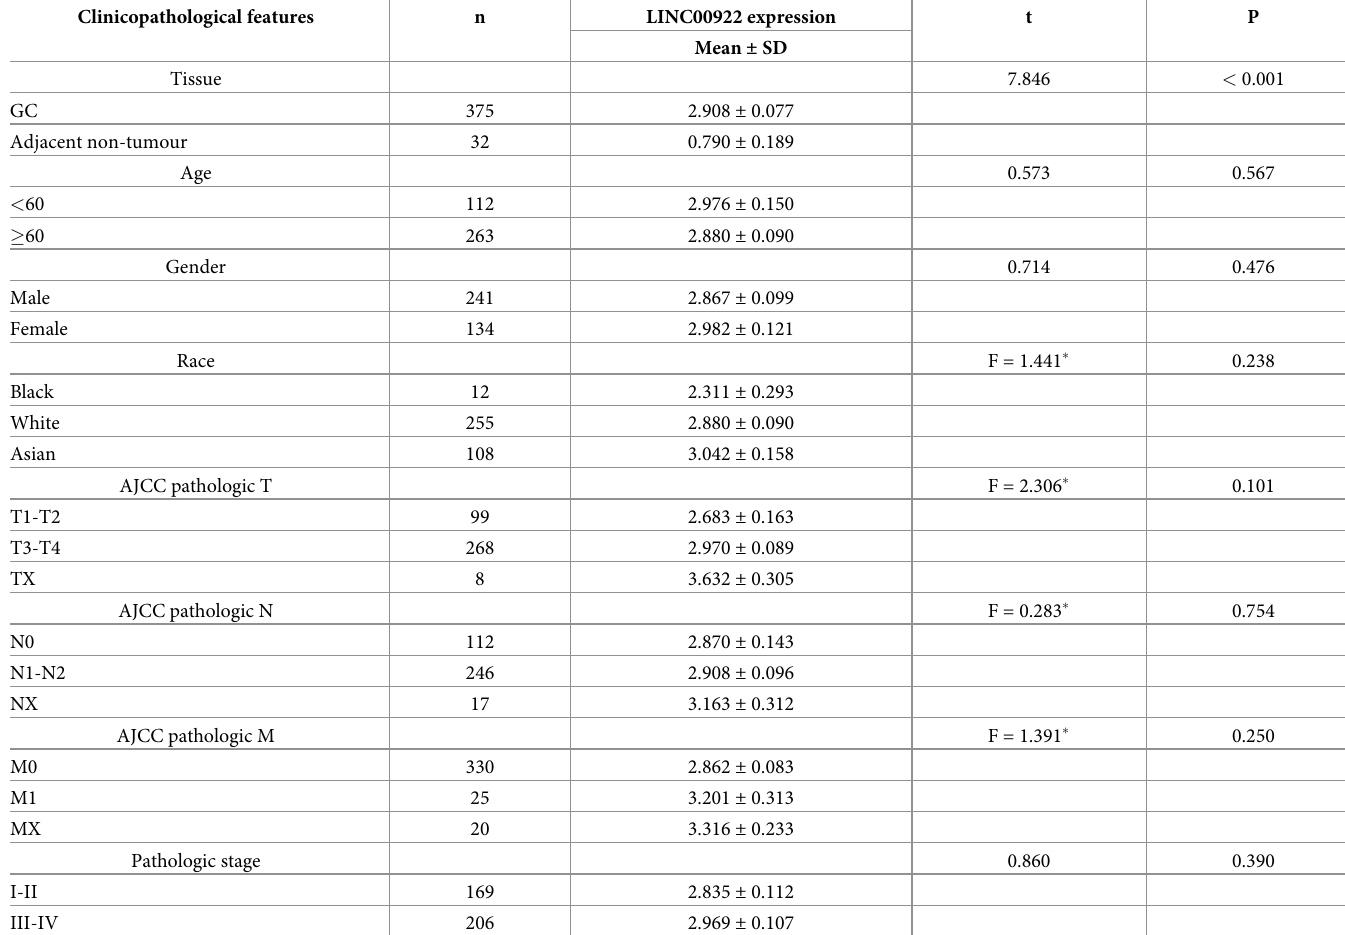
Table 1. Expression of LINC00922 and clinicopathological features in GC patients in TCGA. Clinicopathological